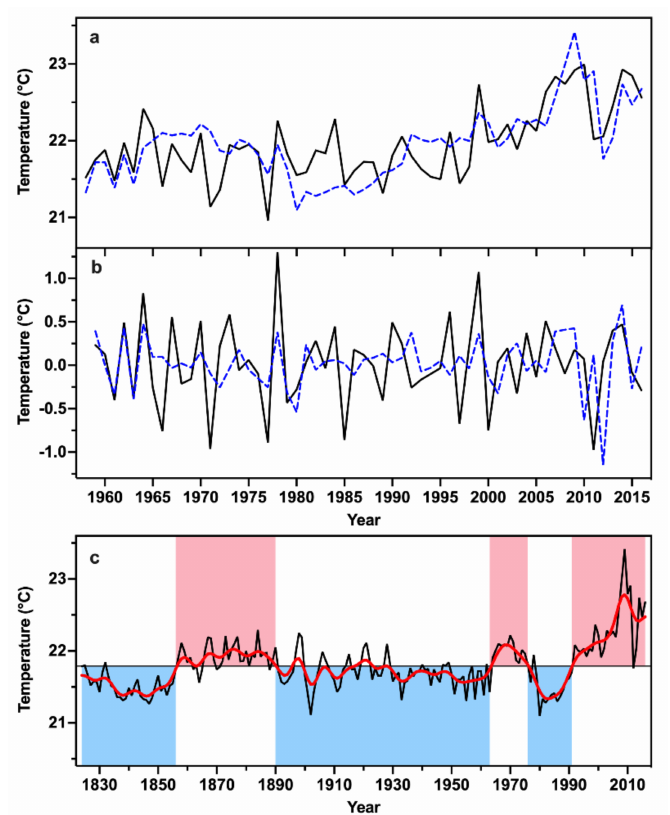
Figure 6. ( a ) Comparison of the estimated (dash line) and the observed pMar-pOct temperature (solid line) during the common period 1958–2016; ( b ) Comparison between their first-differences during 1958–2016; ( c ) The pMar-pOct mean temperature reconstruction from 1824 to 2016 (black line) and its 11-year lowpass FFT filter (red line). The horizontal line denotes the mean value of the reconstruction. The pink and blue shadings denote the warm and cold phases of the reconstruction,